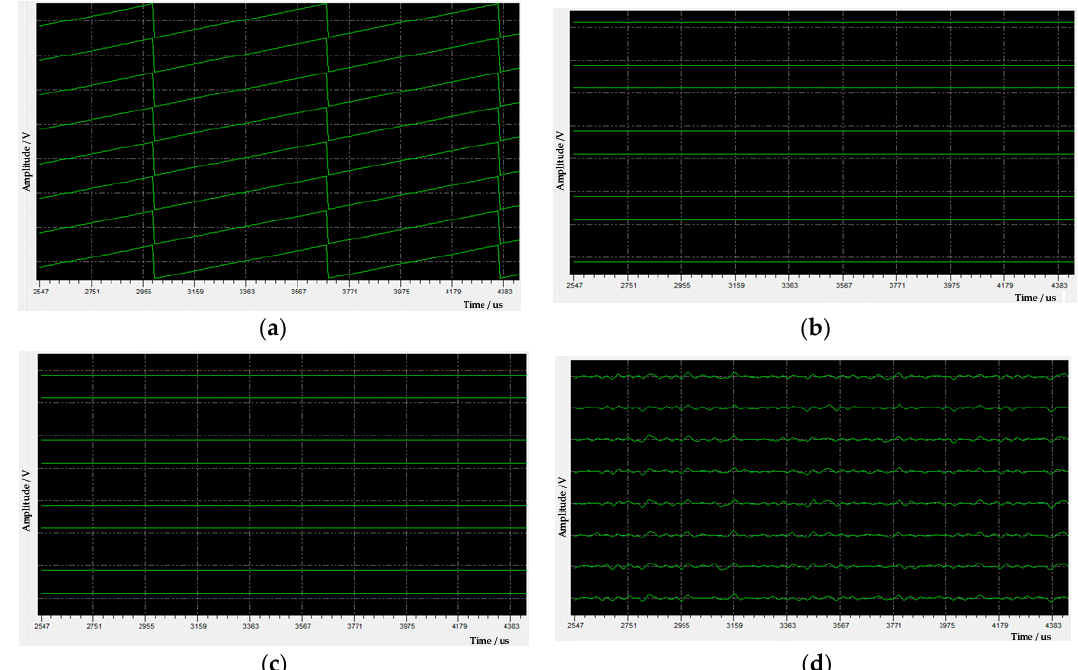
Figure 12. Waveforms of the uploaded data during diagnosis: ( a ) Simulation data from the M3 module; ( b ) simulation data from the synchronous serial bus (SSB) bus; ( c ) simulation data from analog-to-digital converters (ADC) output; and ( d ) normal noise waveforms.